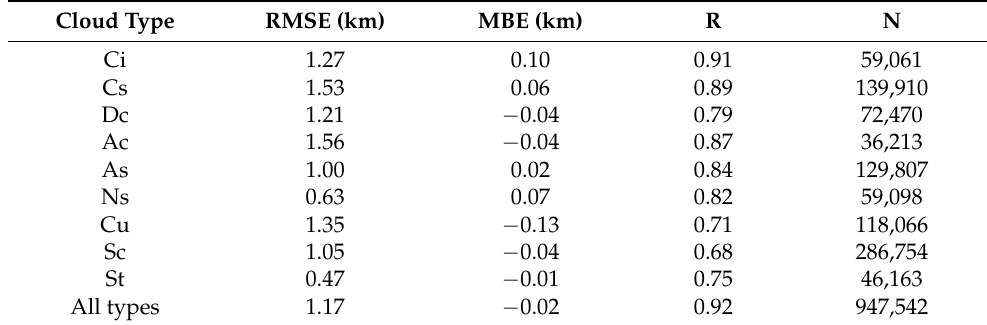
Table 3. The performance of RF-CBH for different cloud